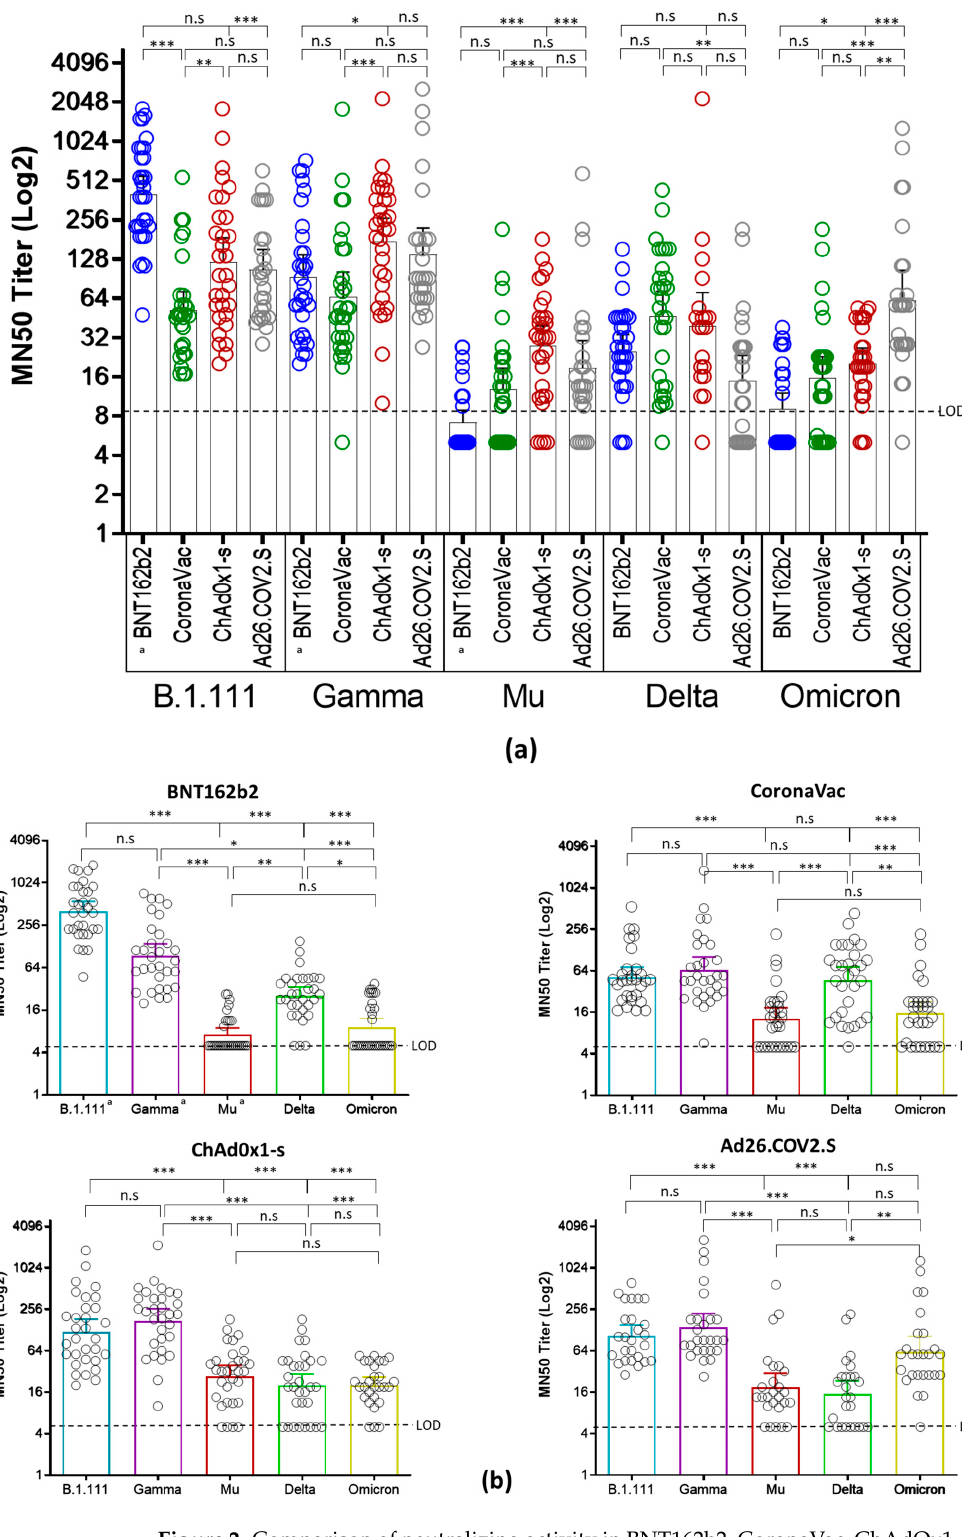
Figure 2. Comparison of neutralizing activity in BNT162b2, CoronaVac, ChAdOx1, and Ad26.COV2.S ‐ vaccinated individuals by SARS ‐ CoV ‐ 2 variants. ( a ) Comparison of GMTs between vaccines against each SARS ‐ CoV ‐ 2 variant. ( b ) Comparison of GMTs between SARS ‐ CoV ‐ 2 variants for each vaccine. *: p < 0.01, **: p < 0.001, ***: p < 0.0001. n.s: no significant. LOD: limit of detection. a : data of nAb titers from BNT162b2 ‐ vaccinated individuals were reported previously [4] and re ‐ ana ‐ lyzed considering a limit of detection of 1:10. Table 2. Summary of vaccine antibody responses against SARS ‐ CoV ‐ 2 variants.